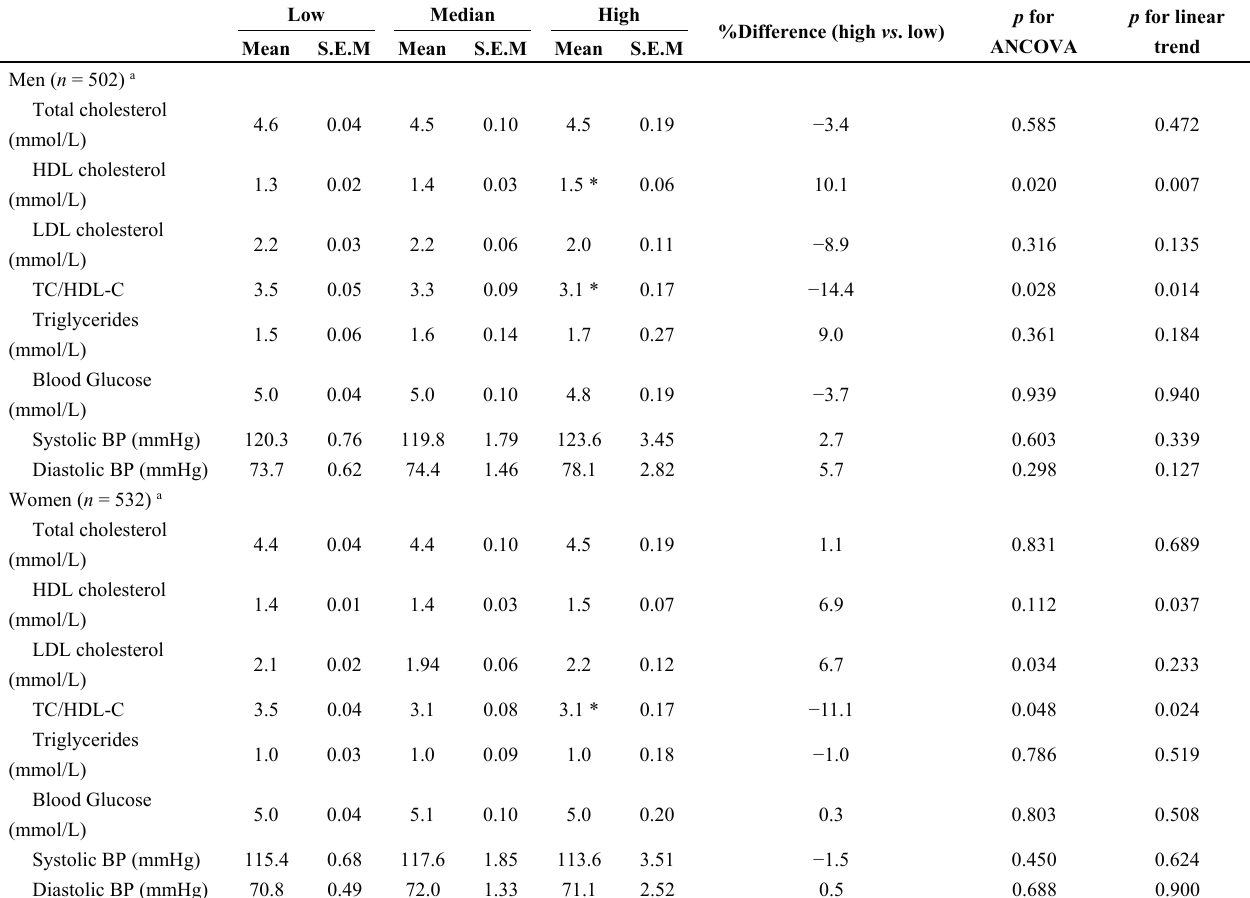
Table 3 . Covariable-adjusted means of parameters by three DF intake Groups. Low Median High